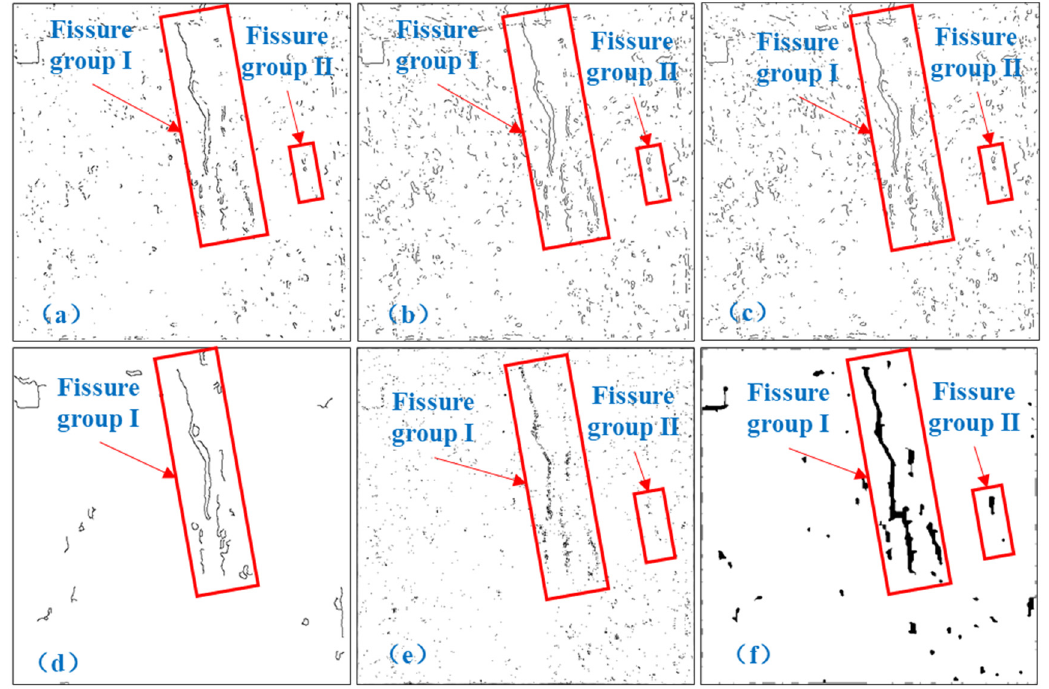
Figure 8. Results of mining-induced ground fissure detection using multiple edge detection methods for the infrared image. ( a ) Roberts operator. ( b ) Sobel operator. ( c ) Prewitt operator. ( d ) Canny operator. ( e ) Laplacian operator. ( f ) Proposed method. Table 2. The evaluation indexes scores of multiple edge detection methods for the infrared image.